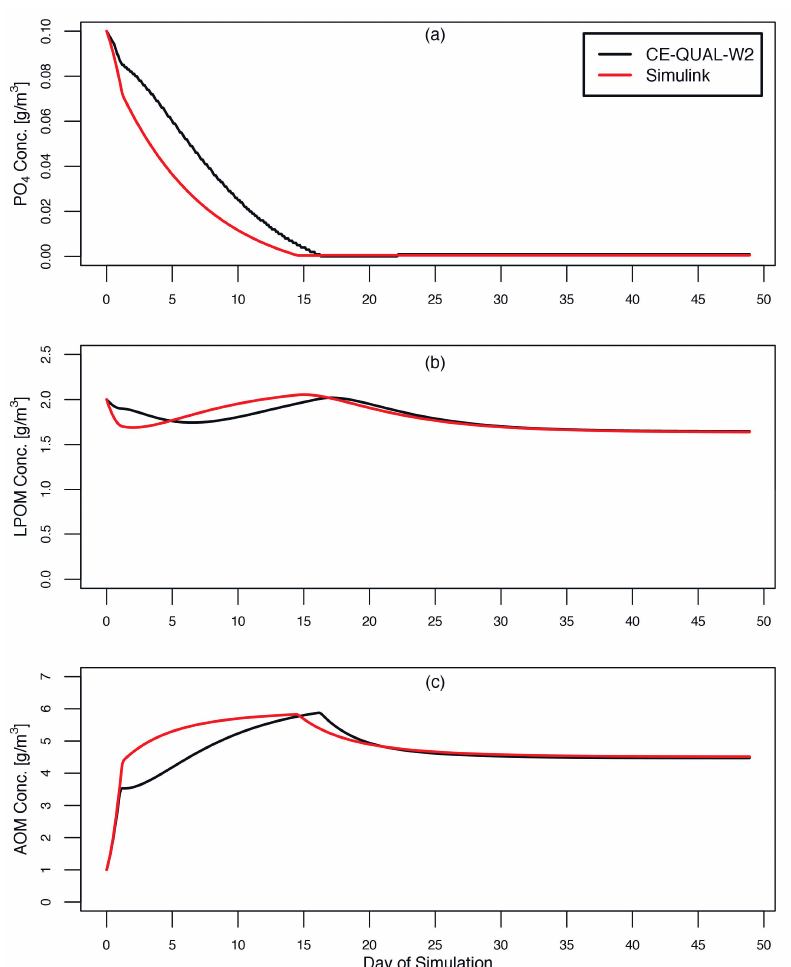
Figure 11. Comparison of model predictions in the surface layer for orthophosphate (PO 4 , top panel), labile particulate organic matter (LPOM, middle panel), and algal organic matter (AOM, bottom panel) for a test case of a pond modeled as one (Simulink) or two (CE-QUAL-W2) horizontal segments. For the CE-QUAL-W2 case, the most downstream of the two horizontal segments is